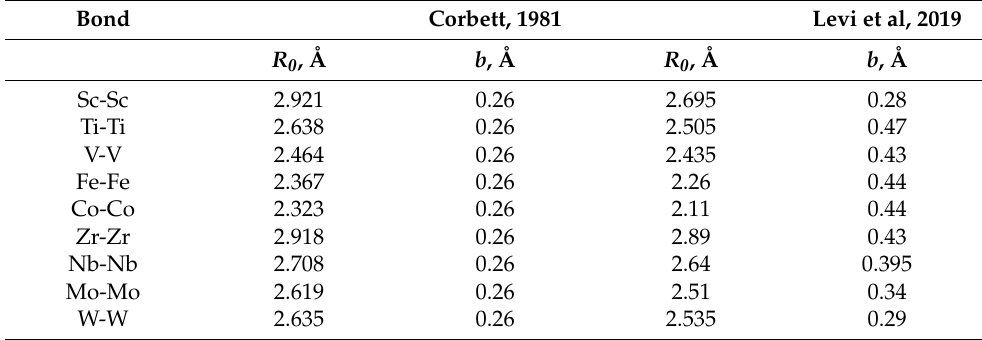
Table 1. Comparison of the bond valence (BV) parameters for the metal–metal pairs used by Corbett [30] and Levi et al.